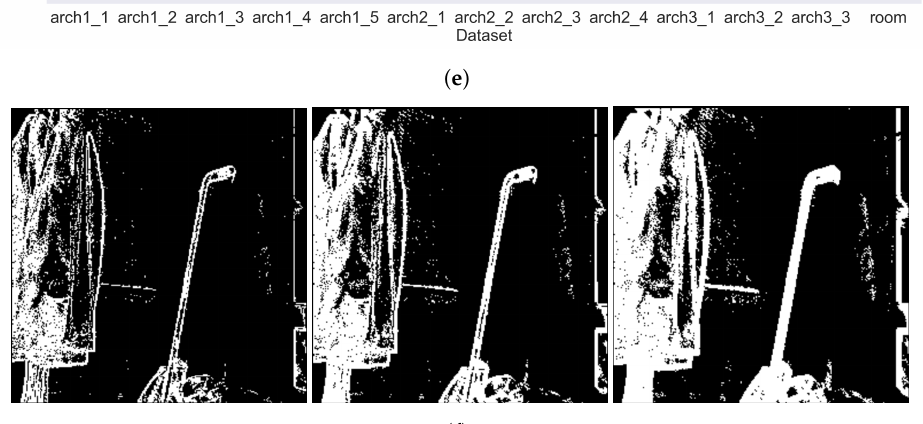
Figure 5. Example scenes (images from OpenCV website) ( a ) “room” from RealisticRendering , ( b ) “arch1” from ArchinteriorsVol2Scene1 , ( c ) “arch2” from ArchinteriorsVol2Scene2 , ( d ) “arch3” from ArchinteriorsVol2Scene3 , and analysis of the simulated datasets: ( e ) angular velocity mean and vari- ances of all simulated datasets, and ( f ) event images demonstrating rotations of 0.25 ◦ , 0.5 ◦ , and 1.0 ◦ , from left to